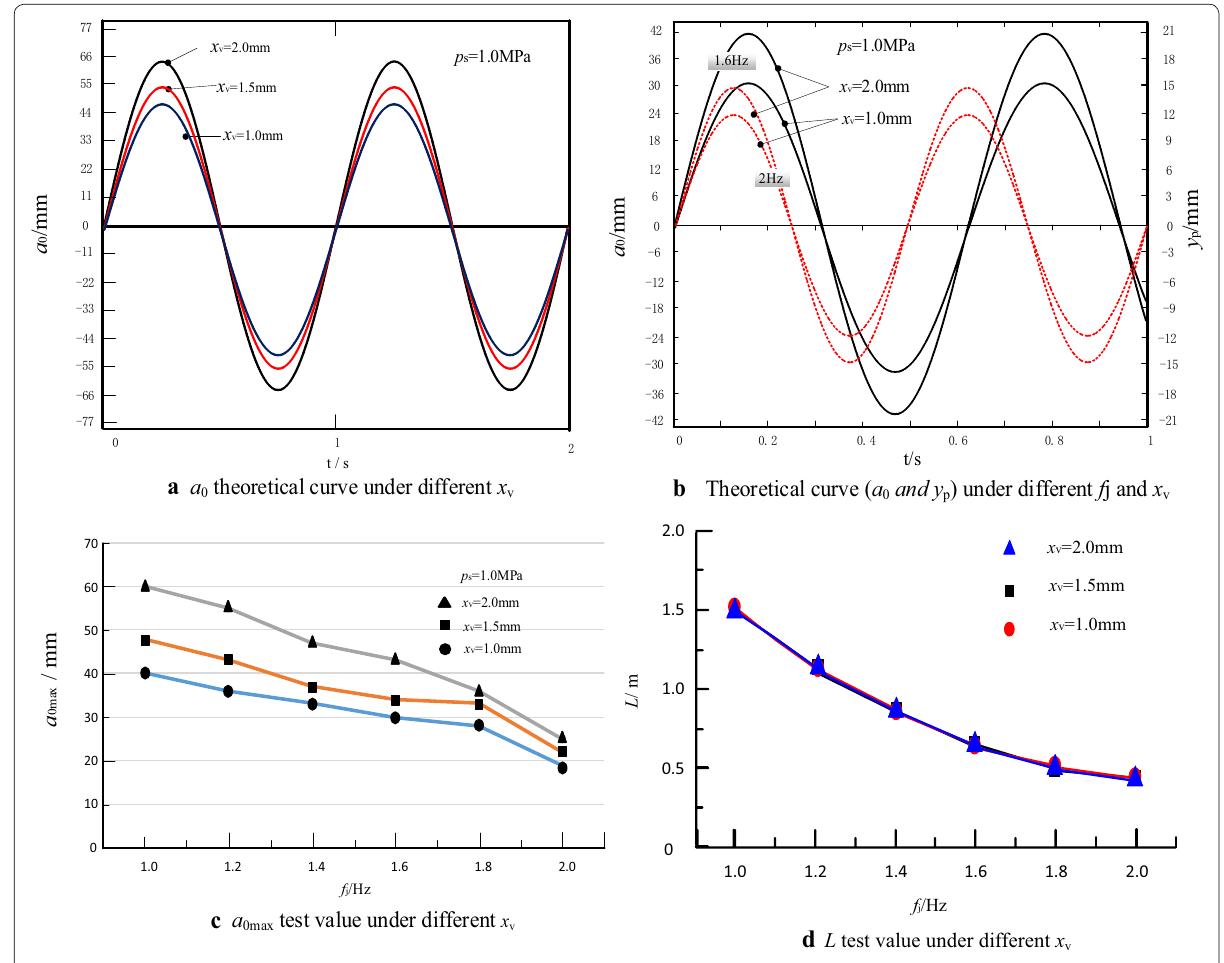
4.1 Influence of Different x and f on Wave Simulation v j Figure 6 and Figure 7(a) show the y p - t and a 0 - t curves under different x v at the working frequency of 1 Hz. From equation S 2 x v y vi , Figure 6 and Figure 7(a), S v is deter- = mined by x v , directly affecting y p and a 0 , Thus, x v is the crucial factor for the motion amplitude of hydraulic cyl- inder and wave amplitude, and the bigger x v is, the bigger S v , y p and a 0 will be. Under the condition of 1.0 MPa (oil supply pressure), 1 Hz (Plate motion frequency, T 1 1.54), = 2.0 mm (Axial opening width), the maximum wave ampli- tude can reach to 64 mm. It can be seen from Figure 6 and Table 5 that test value and theoretical value in the maxi- mum wave amplitude a 0max agree relatively well. Figure 7(b) shows a 0 and y p under different work fre- quencies at 1.0 MPa oil supply pressure. From Fig- ure 7(b), it can be seen that when work frequency is 1.6 Hz ( T 1 2), the maximum amplitude of the cylinder is 16 =